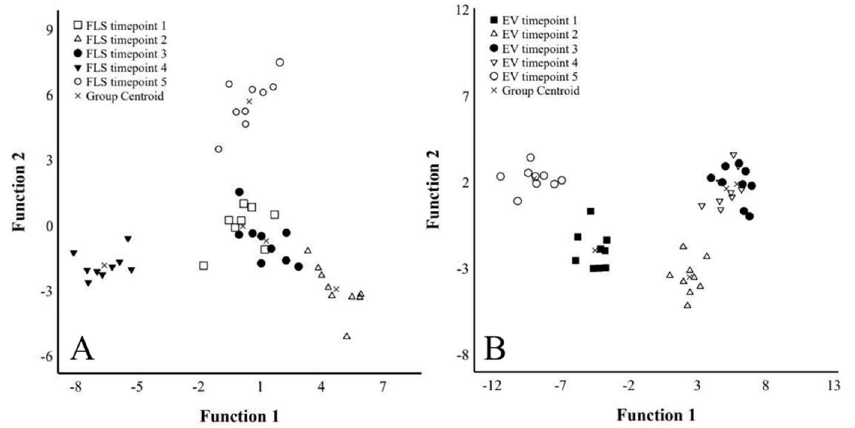
Figure 8. Discriminant analysis of fatty acid proportions in fibroblast-like synoviocytes (FLSs) and extracellular vesicles (EVs) collected during 5 different timepoints: 1 = lag phase, 2–3 = proliferating cells, and 4–5 = high-density cells. (Panel ( A )) presents the FLS data, in which function 1 explained 45.1% of the variance in the dataset and function 2 accounted for 29.7% of the variance. (Panel ( B )) presents the EV fraction, in which functions 1–2 explained 92.1% of the variance in the dataset.